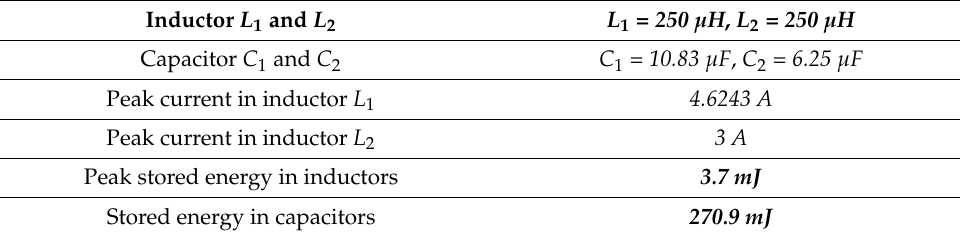
Table 3. Proposed converter